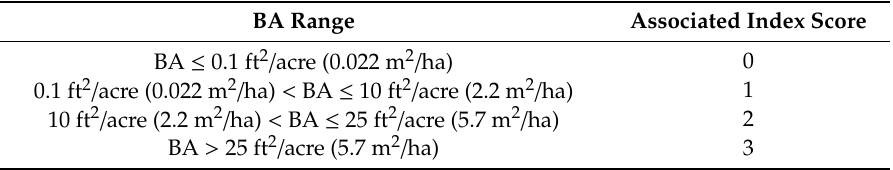
Table 2. Index scores associated with given basal area (BA) ranges. The same classification was used for both the spreader species index and the susceptible species